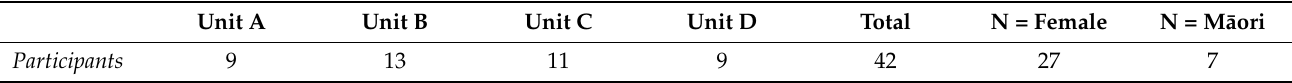
Table 1. Participant